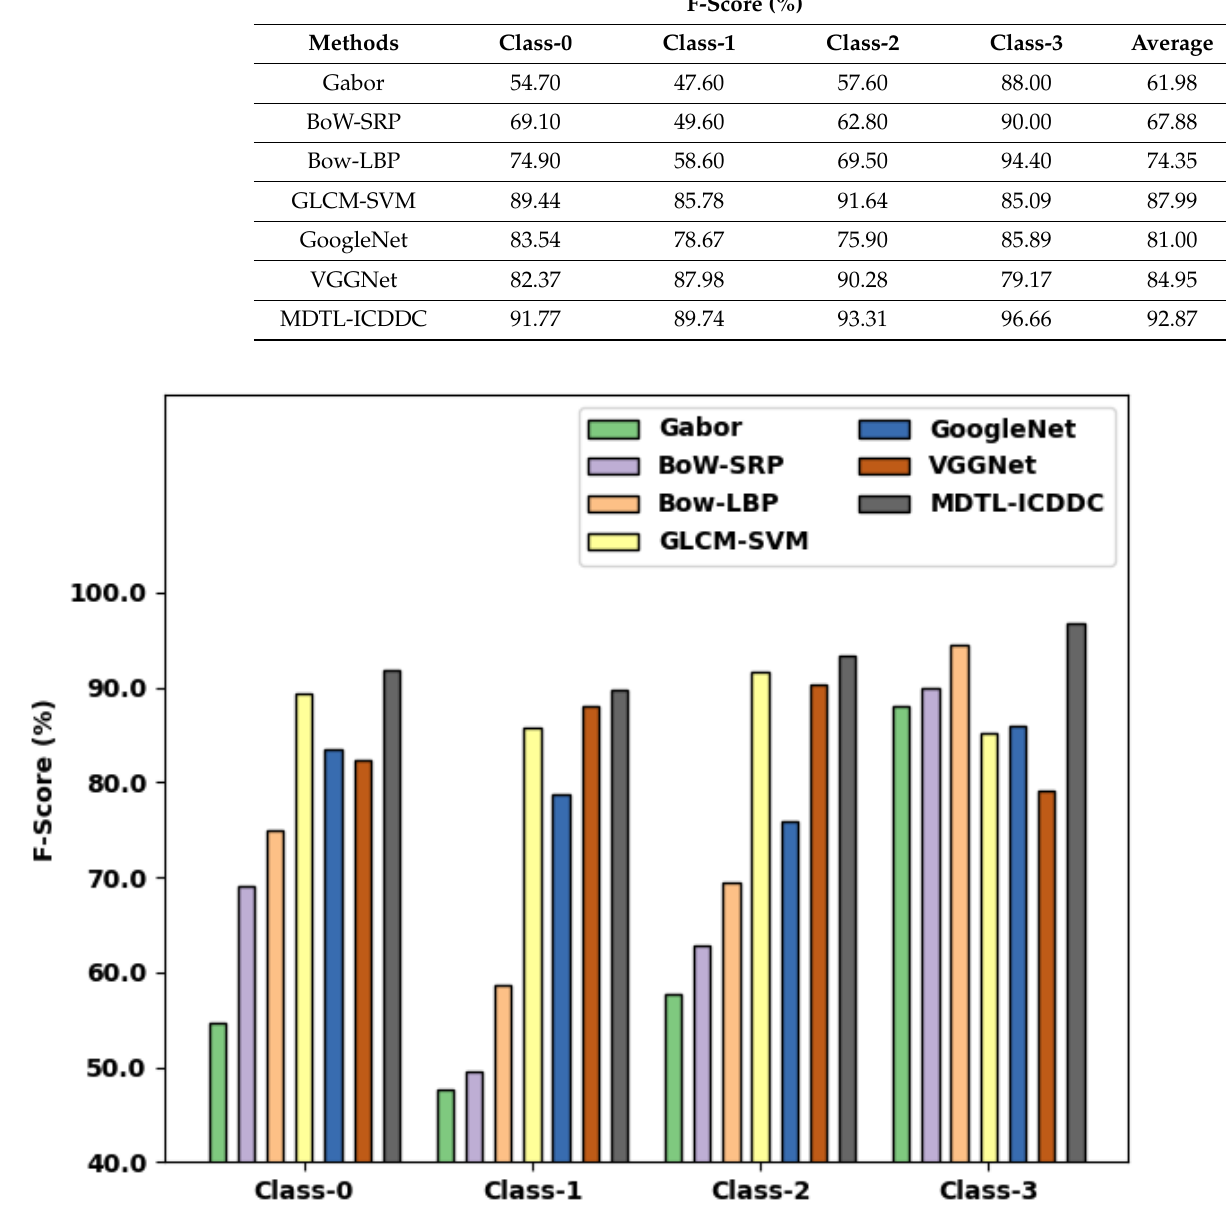
Figure 14. F-score analysis of MDTL-ICDDC technique under various classes.